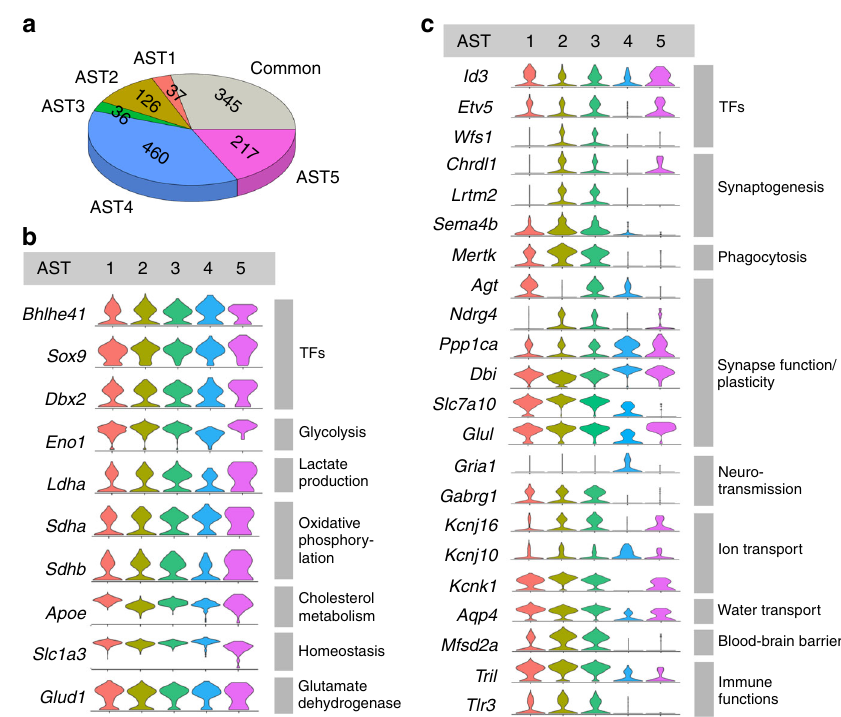
Fig. 3 Identi fi cation of common and differentially expressed genes in astrocytes. a Chart showing the number of genes expressed in at least 60% of sampled astrocytes (common) and the number of genes speci fi cally enriched in each subtype. b Examples of genes common across astrocyte subtypes, classi fi ed by biological function. TFs, transcription factors. c Examples of genes highly enriched in speci fi c astrocyte subtypes, classi fi ed by biological function. Note, some genes, e.g. Gabrg1 ( γ -aminobutyric acid type A receptor γ 1 subunit), could be classi fi ed as either an ion channel or as involved in synaptic function/plasticity. Here, classi fi cation was based on the principal identi fi ed function — ion channel